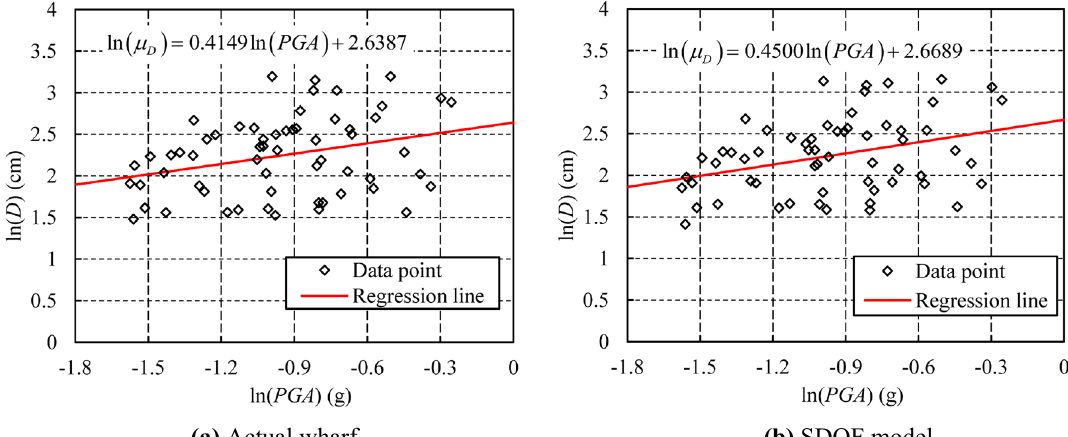
Fig. 8 Probabilistic seismic demand models for actual wharf and SDOF model in case study I